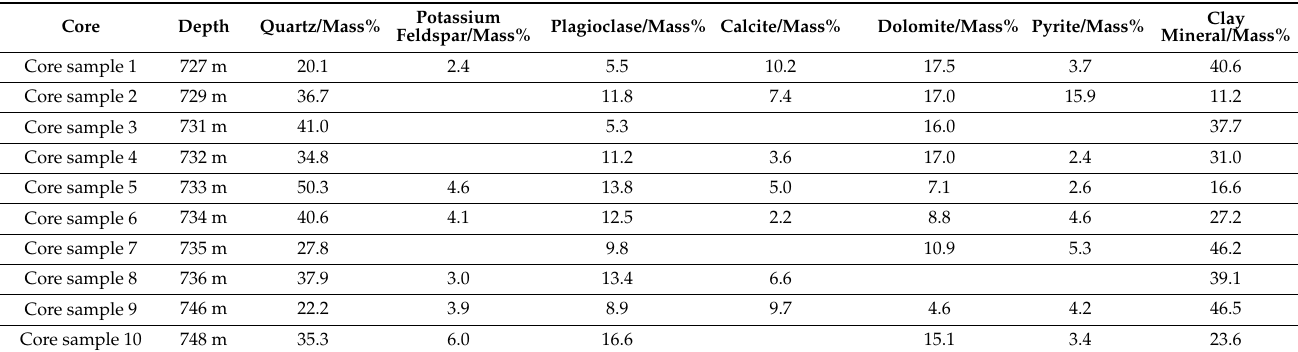
Table 1. Mineral composition of the studied rock samples defined using X-ray